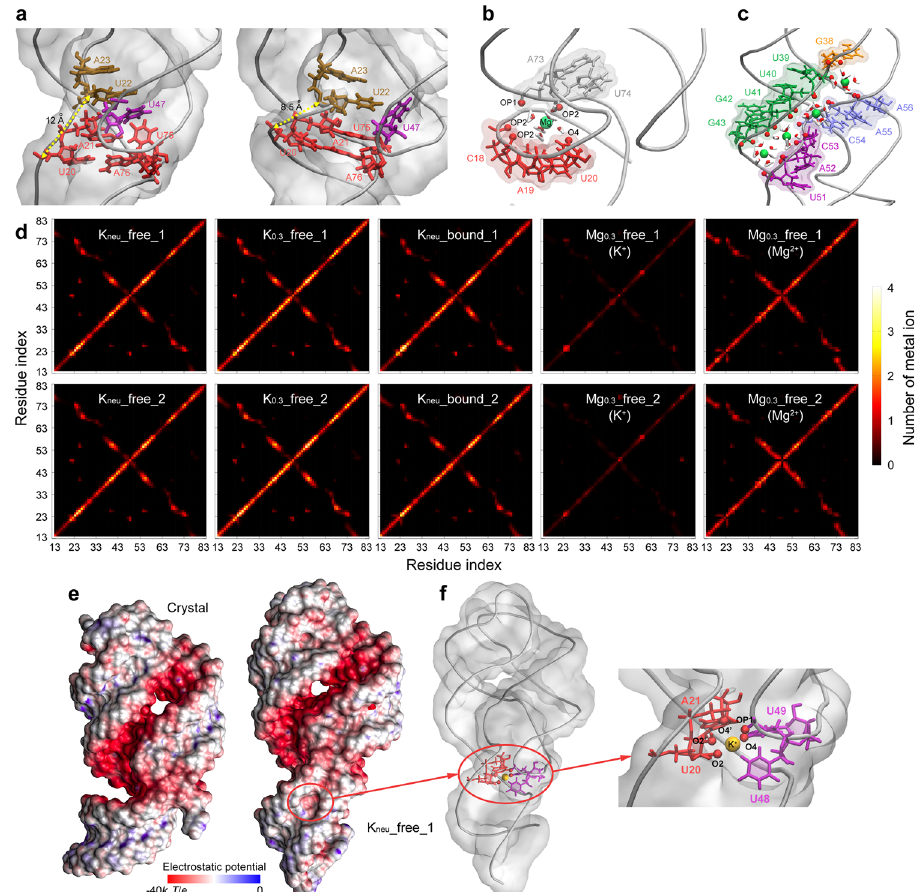
Fig. 4 Details of the interaction pattern between metal ions and AARA structure. a Snapshots of the structure around ligand binding pocket in K neu _free_1 and Mg 0.3 _free_1. d U20-A23 is shown in yellow dashed line, and two key metal ions are also shown in color spheres (K + in orange and Mg 2 + in green). b Detailed structure of C J12-P1 in Mg 0.3 _free_1. Mg 2 + interacts with the surrounding residues through its chelated water molecules. c Arrangement of hydrated Mg 2 + ions in the groove formed by stems P2 and P3 (the two strands connected by J23). d The heat maps generated by computing the number of common metal ions in the range of 6 Å around every two phosphate groups for all eight simulation trajectories. The color bar shows the variations in number of metal ions from 0 (black) to 4 (white). e The electrostatic potential surface of AARA structures from experiment and K neu _free_1. The coloring range of electrostatic potential is from − 40 k B T · e − 1 (red) to 0 (blue). f Detailed view of an important K + ion binding site in K neu _free_1. This site is located in the middle of J23 and J12, and is formed by residues U20, A21, U48, and U49. K + ion in this site will interacts with fi ve oxygen atoms (represented by red spheres), namely O2 and O2 ’ on U20, OP1 on A21, O4 on U48, as well as OP1 on U49, respectively. COMMUNICATIONS BIOLOGY| (2022) 5:1120 |https://doi.org/10.1038/s42003-022-04096-z|www.nature.com/commsbio